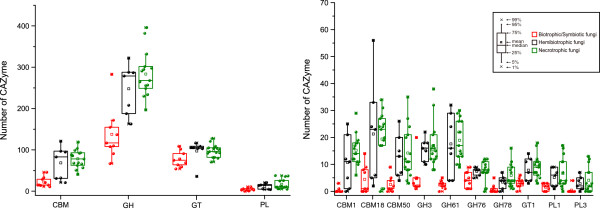
Comparison of CAZymes in different plant pathogenic fungi. (A) The number of CAZymes in each class and CBMs were plotted for biotrophic (red), hemibiotrophic (black), and necrotrophic (green) pathogens. (B) The number of CAZymes in the families that showed significant differences among biotrophic, hemibiotrophic, and necrotrophic pathogens. Differentiation was support by the t test at the significant level with P < 0.01. See Figure 1 for abbreviations.